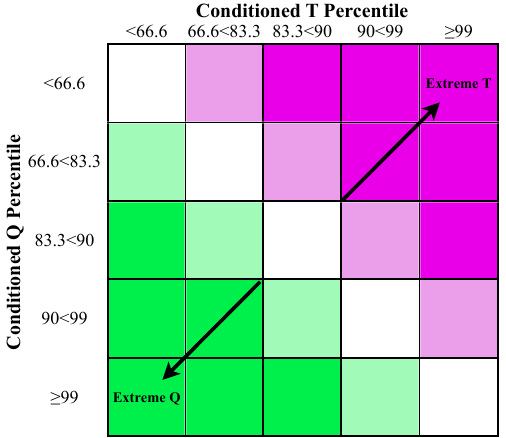
Figure 2. Expected value ranking. T and Q conditioned upon ex- ceedance value of a heat stress or moist thermodynamic metric. The T and Q values are compared to their respective time series as a percentile. These T and Q percentiles are binned and are compared to each other. Extreme Q are greens and extreme T are